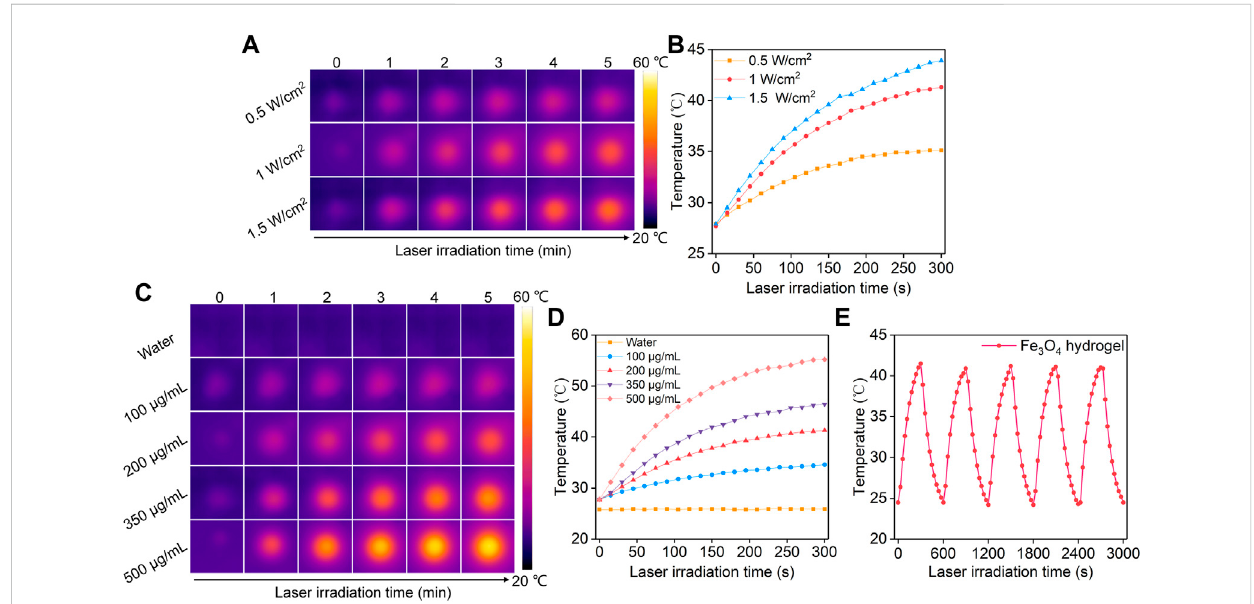
FIGURE 4 Evaluation of photothermal conversion ef fi ciency of Fe 3 O 4 hydrogels. (A) Thermal imaging of Fe 3 O 4 hydrogels under 808 nm laser irradiation at power densities of 0.5, 1.0, and 1.5 W/cm 2 . (B) Temperature pro fi les of Fe 3 O 4 hydrogels under 808 nm laser irradiation at different power densities. (C) Thermal imaging of hydrogels at concentrations of 100, 200, 350, and 500 μ g/mL under 808 nm laser irradiation at a power density of 1.0 W/cm 2 . (D) Temperature pro fi les of Fe 3 O 4 hydrogels at different concentrations under 808 nm laser (1.0 W/cm 2 ) irradiation. (E) The photothermal stability evaluation of Fe 3 O 4 hydrogels after 5 laser cycles.